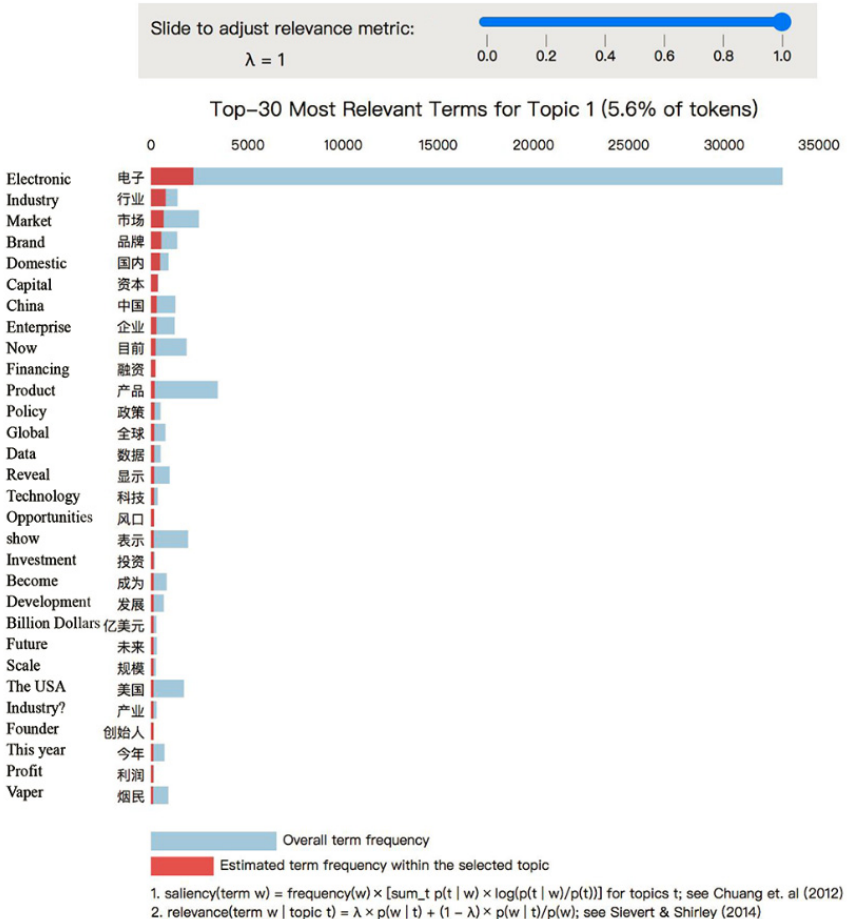
Figure 5. Top 30 most relevant terms for topic 1 (5.6% of Tokens)